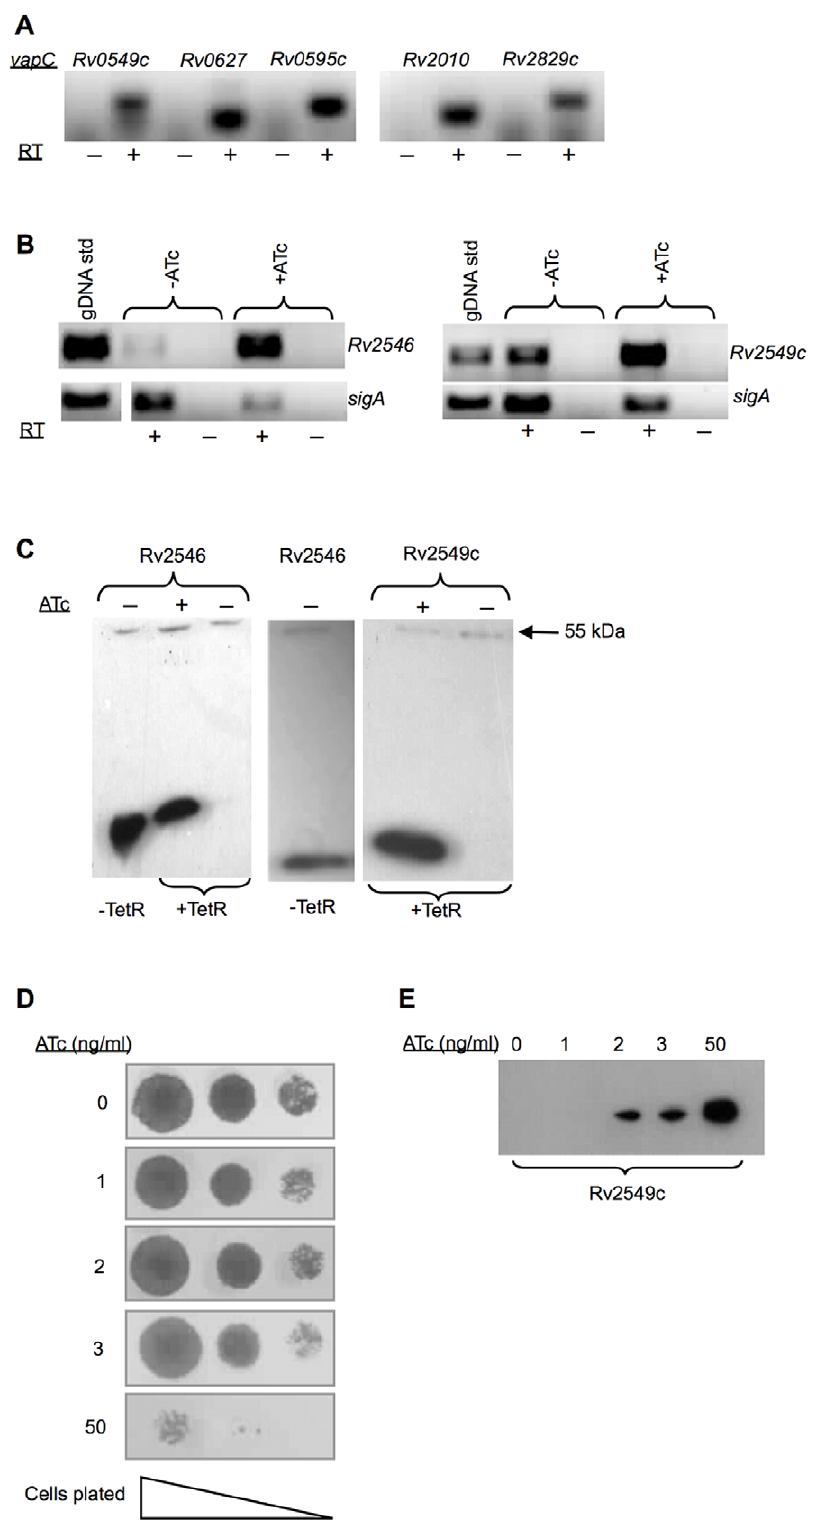
Figure 4. Analysis of ATc-regulated vapC expression in mycobacteria . Expression was analyzed by RT-PCR ( A and B ) and detection of expressed proteins by epitope tagging ( C ). RT-PCR was carried out using mRNA samples obtained from ( A ) induced cultures of wild type Mtb (6 h treatment with ATc at 25 ng/ml); and ( B ) ATc-induced and uninduced cultures of M. smegmatis (1 h treatment with ATc at 50 ng/ml) over-expressing various vapC toxins under the control of the P myc1 tetO promoter. Samples obtained with ( + ) and without (-) reverse transcription (RT) were compared to distinguish cDNA from genomic DNA contamination. ( C ) Cellular fractions isolated from M. smegmatis were subjected to Western blot analysis using the anti-FLAG M2 antibody to detect the epitope-tagged VapC Rv2546 and Rv2549c proteins. Cultures were grown in either the presence ( + ) or